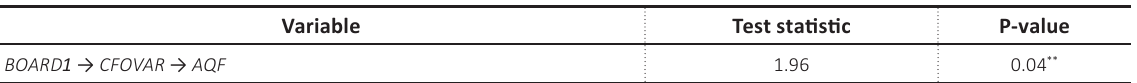
Source: Data processed with LISREL.